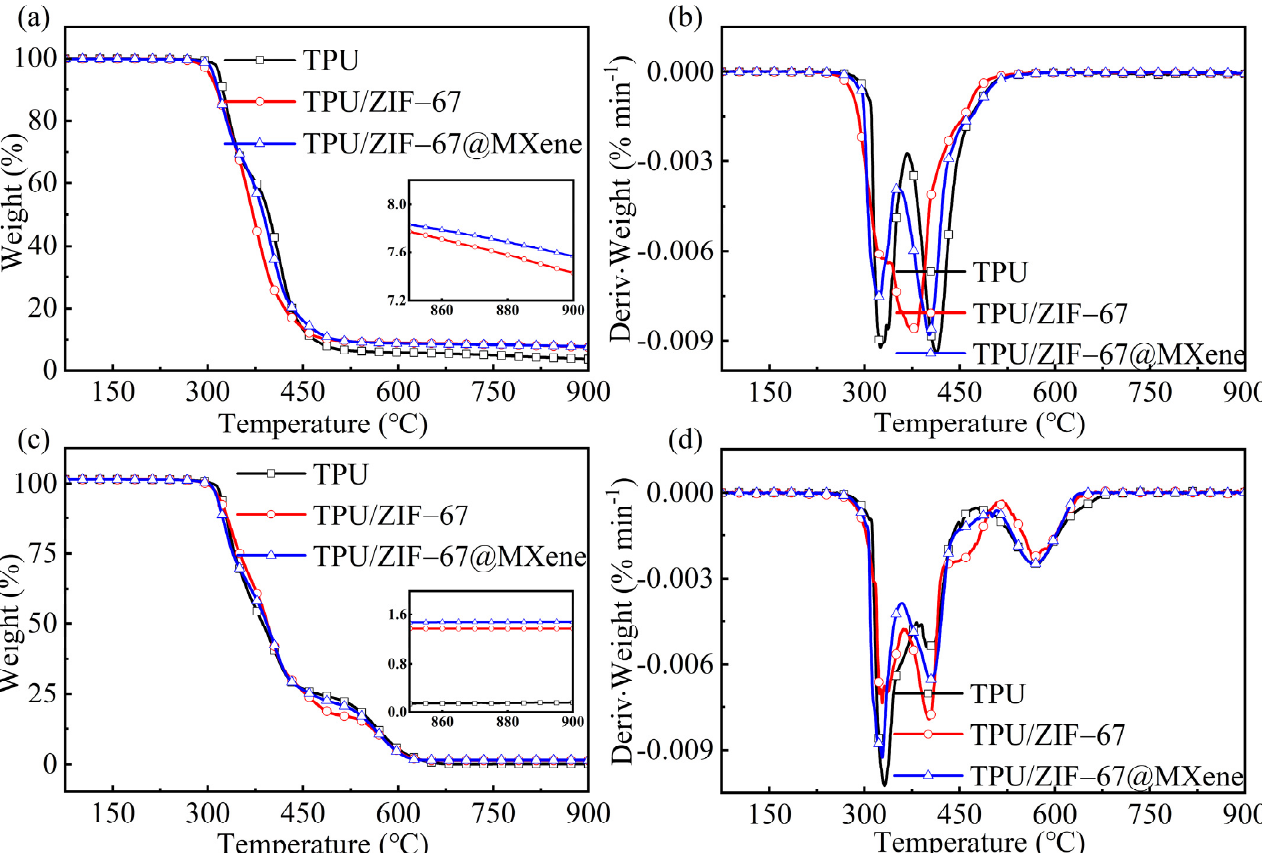
Figure 4. ( a ) TGA and ( b ) DTG curves of TPU composites under nitrogen atmosphere and ( c ) TGA and ( d ) DTG curves of TPU composites under air atmosphere.